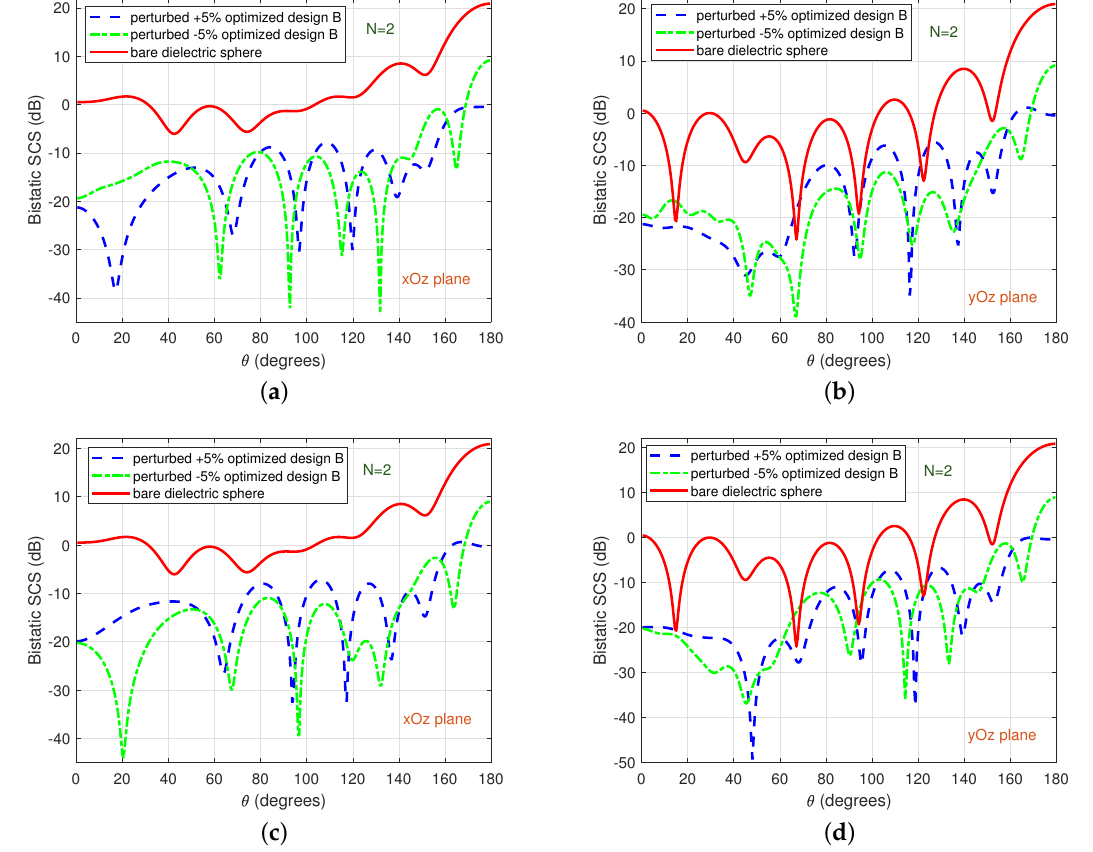
Figure 12. Cloaking performance for the optimized design B of Figure 7a,b after perturbing ( a , b ) the permittivity (cid:101) 1 and ( c , d ) the permeability µ 1 by ±